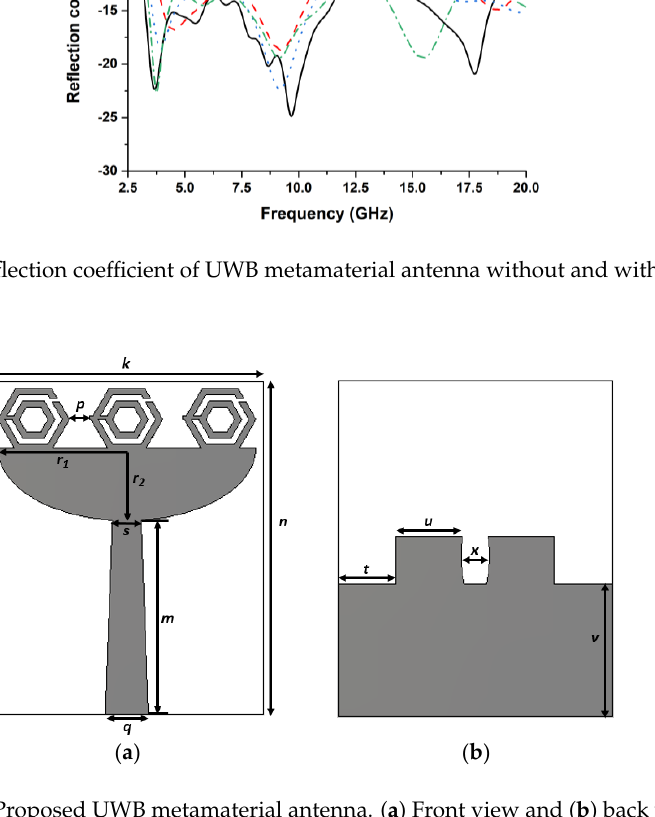
Figure 6. Proposed UWB metamaterial antenna. ( a ) Front view and ( b ) back view. Table 3. Design parameters of the proposed antenna.